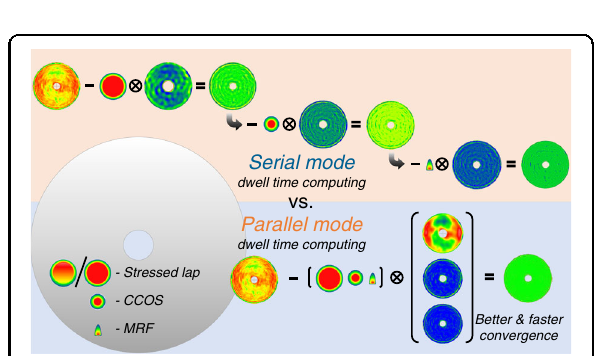
Fig. 7 Schematic diagram of the developed large heterocercal stressed lap. a ⌀ 300 mm heterocercal stressed lap device. b Typical motion modes and TIFs during process